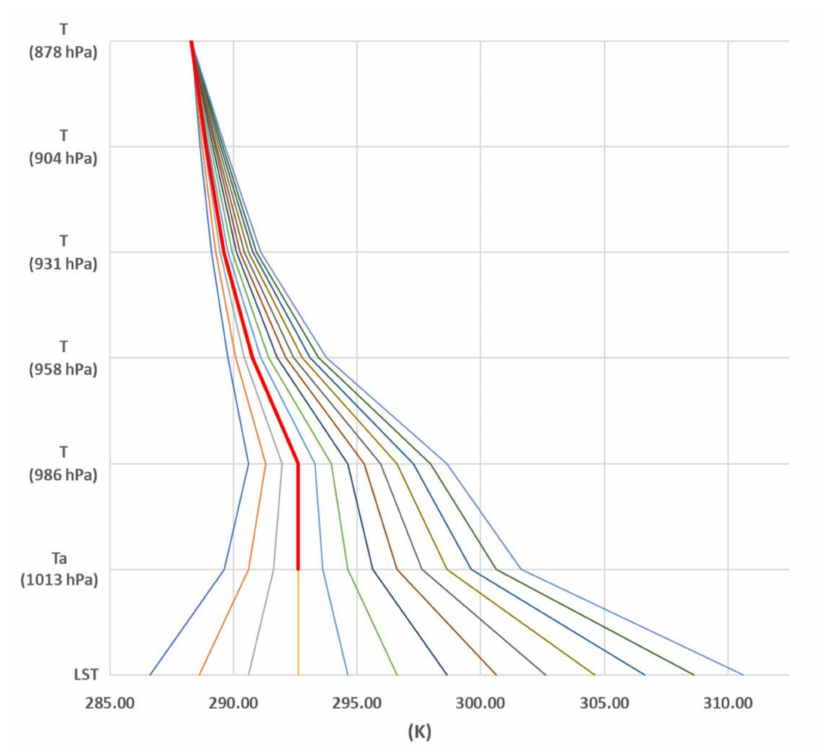
Figure 2. Conceptual atmospheric vertical profiles according to diurnal variation of land surface temperature (LST) and air temperature (bold red line: SeeBor profile; other lines: diurnal variation of air temperature